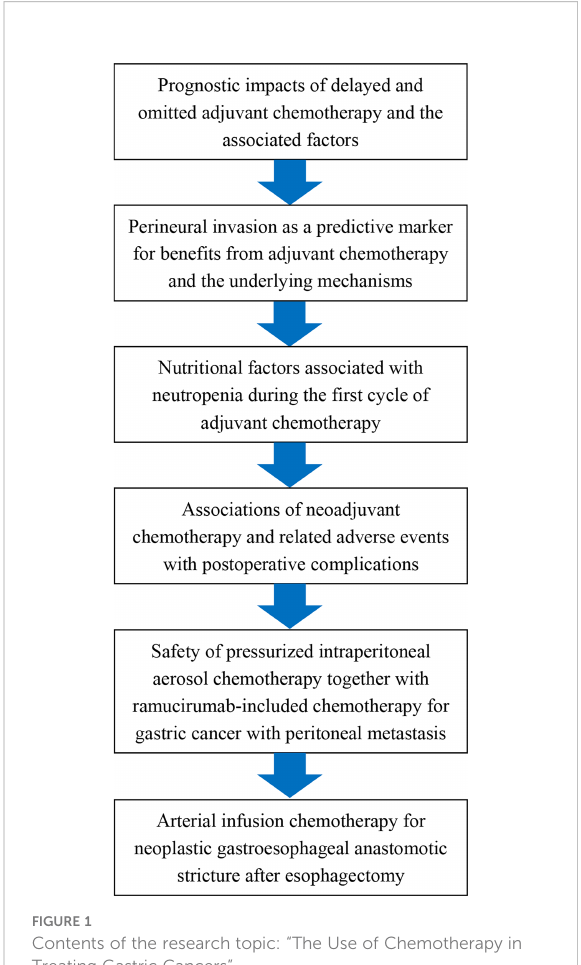
FIGURE 1 Contents of the research topic: “ The Use of Chemotherapy in Treating Gastric Cancers ”